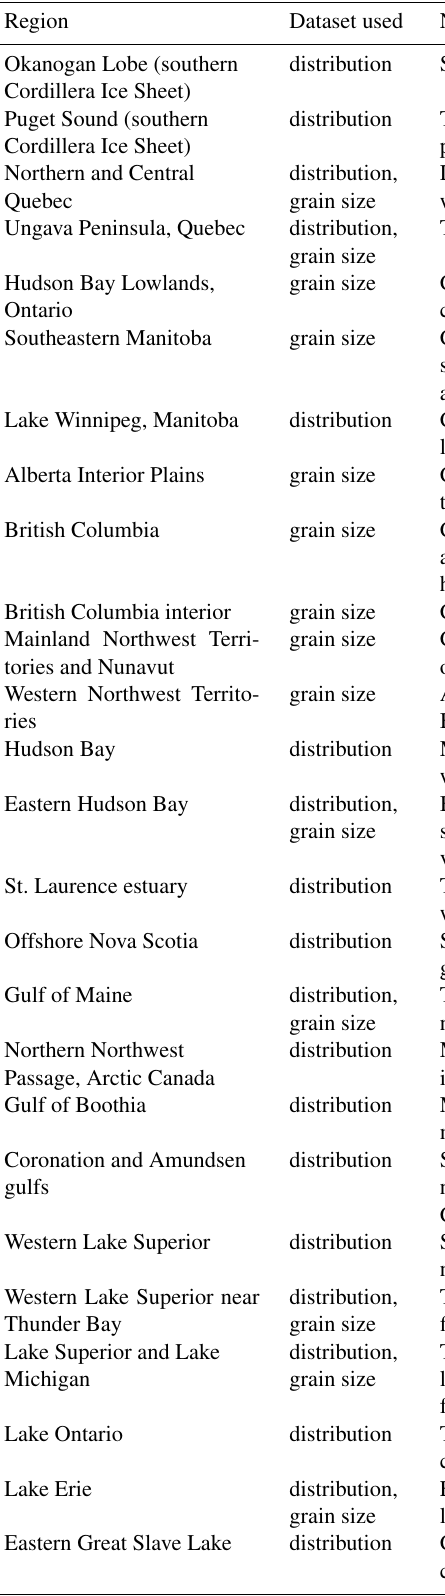
Table 2. Supplementary resources used for the creation of the distribution and grain size dataset.